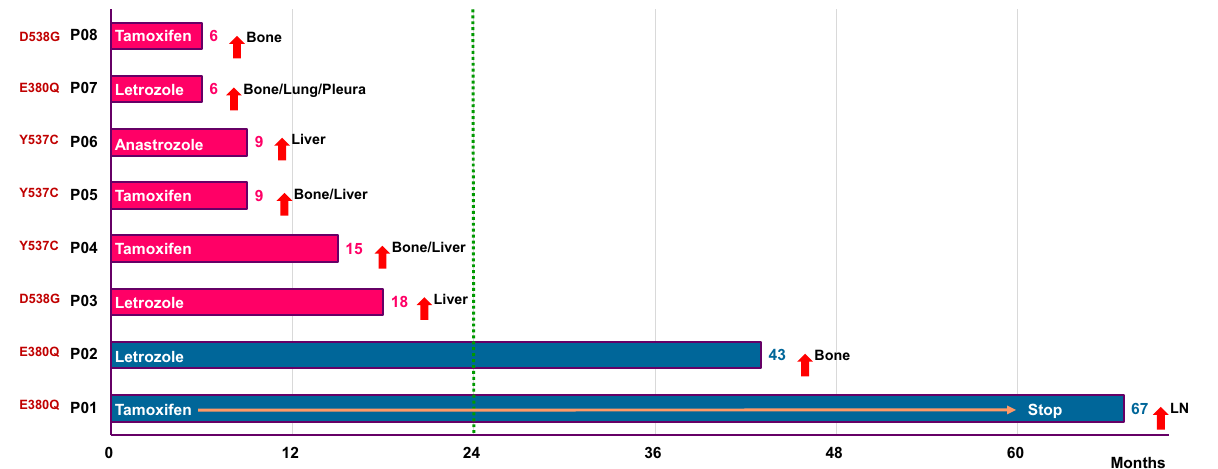
Fig. 4 Recurrence types according to responsiveness to adjuvant endocrine therapy in eight patients with ESR1 mutations who received adjuvant endocrine therapy. Among eight patients, six patients belonged to primary endocrine resistance, and two patients belonged to secondary endocrine